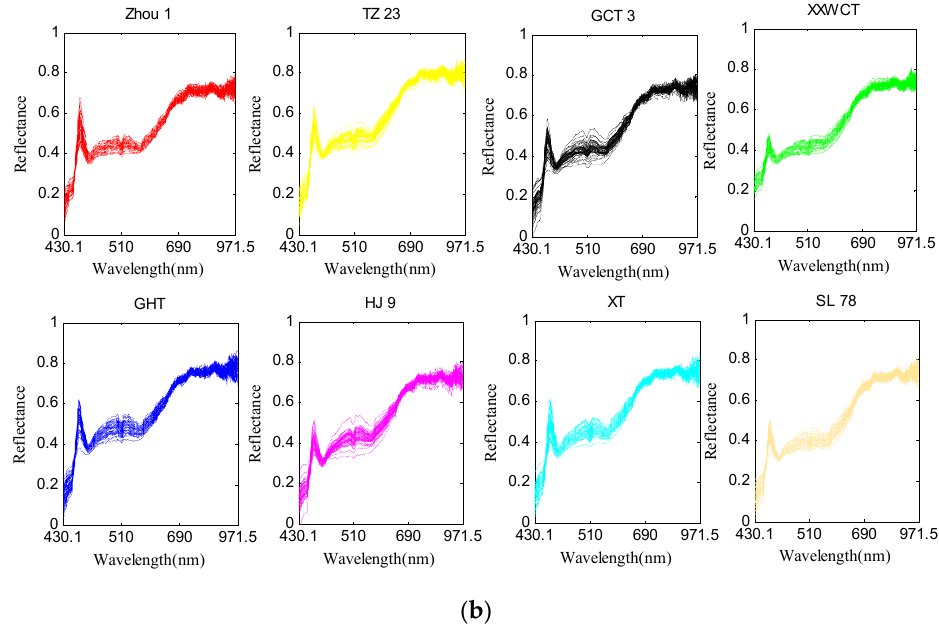
Figure 6. The processing of Procrustes Analysis (PA): ( a ) Raw spectra of eight maize varieties in the train set, and ( b ) PA-preprocessed data for the raw spectra. The abscissa axis represents the unit of the wavelength (nm), and the ordinate axis shows the relative reflectance.